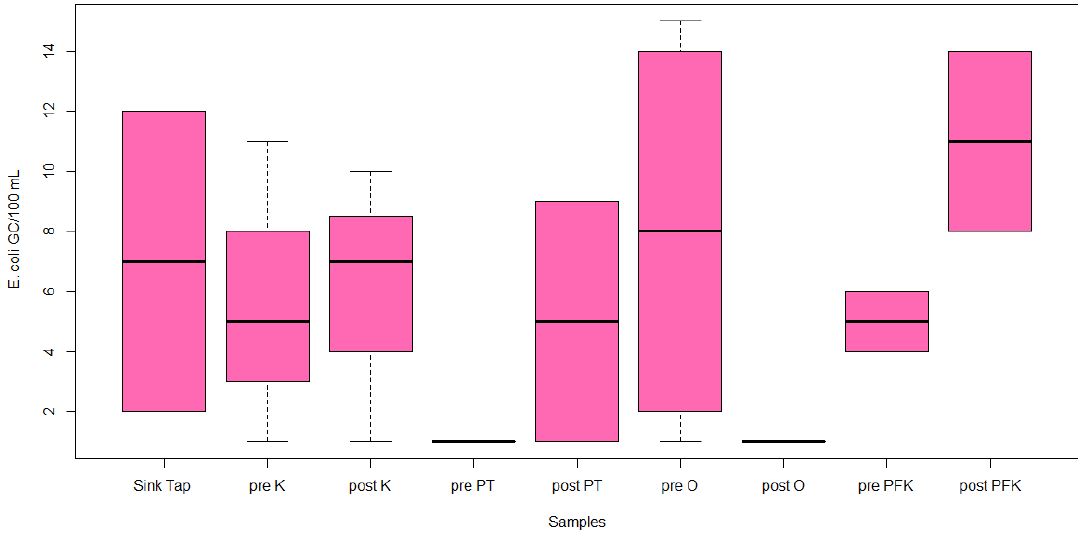
Figure 4. Distribution of E. coli ( gene copies/100 mL) by qPCR (outside (O), inside kitchen (K), pressure tanks (PT), and post-filtration kitchen tap (PFK).